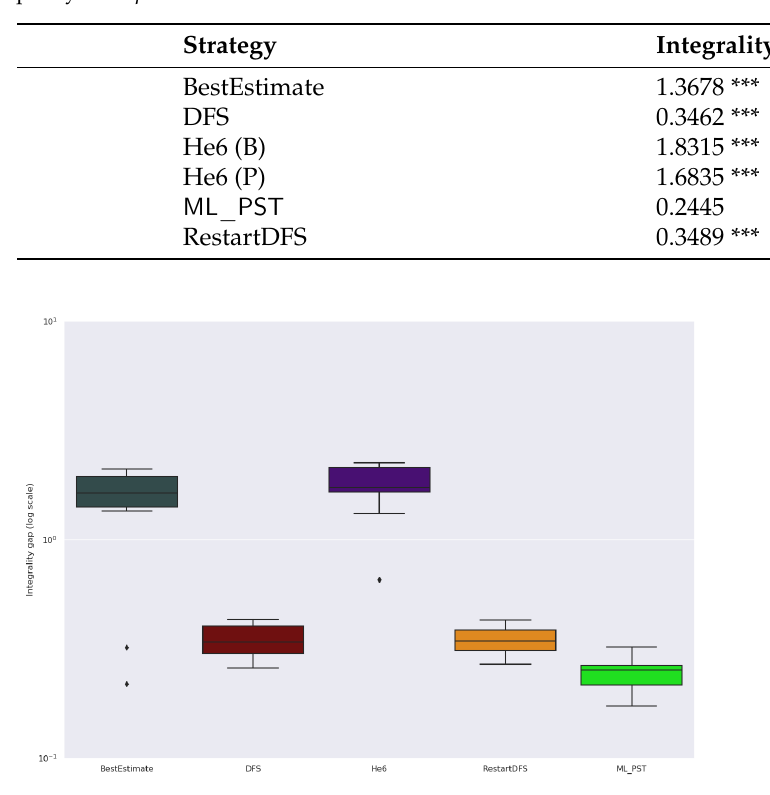
Figure 5. Hard set cover instances: integrality gap of various heuristic strategies. Note log scale on y-axis. ML_PST outperforms the compared